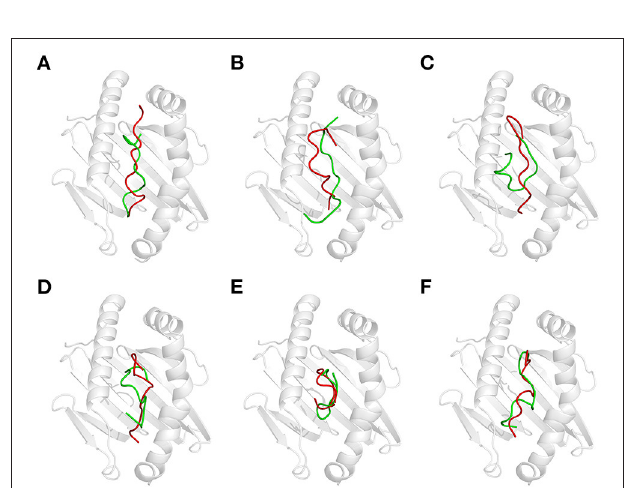
FIGURE 3 | Effect of thermal treatment on the recognition of gluten epitope peptides (GEPs). In each panel, the white cartoon representation presents the HLA-DQ2 with the epitope presenting groove facing outwards. The ribbon diagram represents each GEP. The green ones represent native GEPs at pH 7.5 and 25 ◦ C, and the red ones represent the thermal treated one at pH 7.5 and 100 ◦ C. (A–F) GEP1–GEP6, respectively.